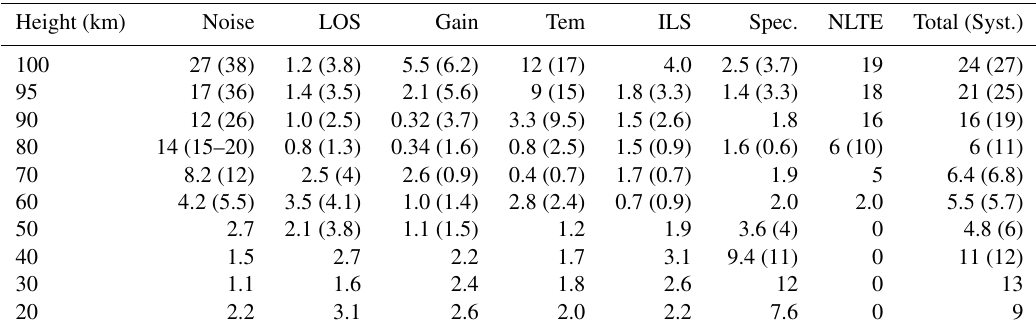
Figure 5. Errors of the retrieved O 3 VMR for daytime (a) and nighttime (b) in relative values. The different sources are described in the legend of Table 4. Table 4. Summary of main errors (1 σ ) of ozone VMR in percent. Errors refer to nighttime conditions with daytime values, when different, in parentheses. “NLTE” includes errors due to uncertainties in the collisional rates of the non-LTE model and in the atomic oxygen (see text). “Total (Syst.)” is the root sum square of all systematic errors (noise is not included). LOS stands for line of sight, “Tem” for temperature, ILS for instrument line shape, and “Spec.” for